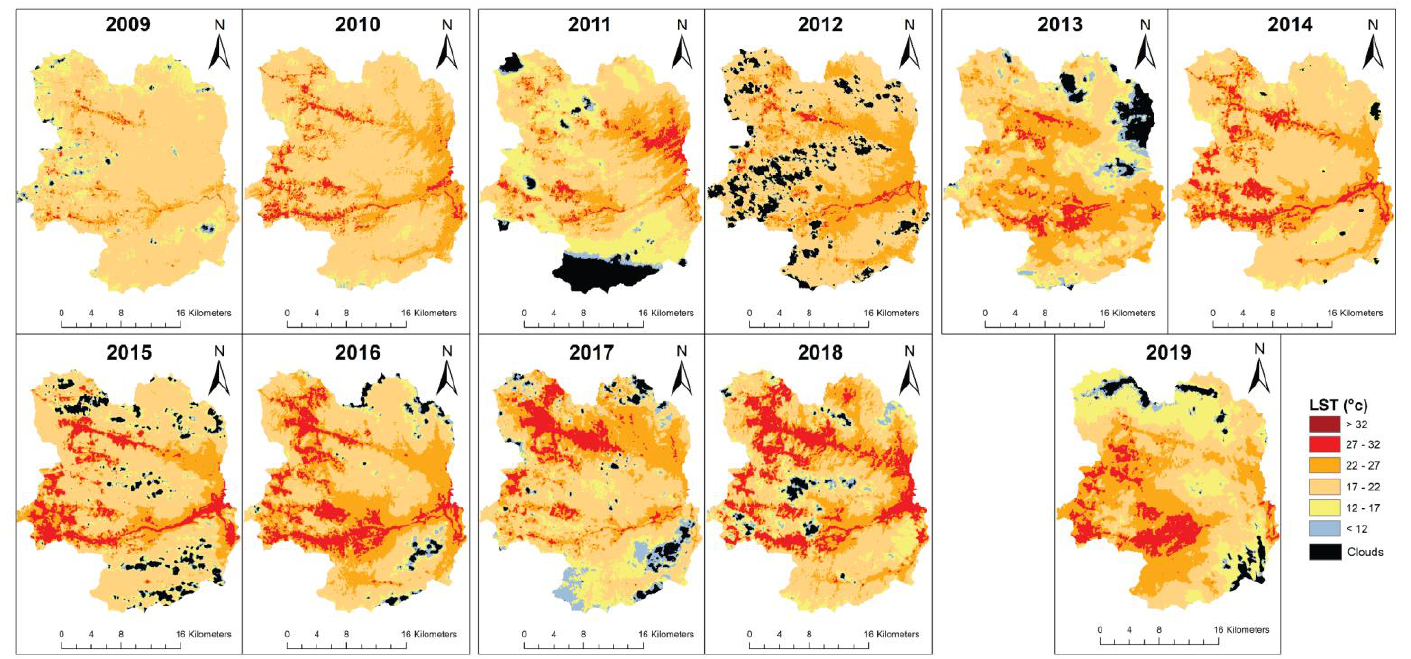
Figure 9. Images showing land surface temperature for the period 2009–2019.